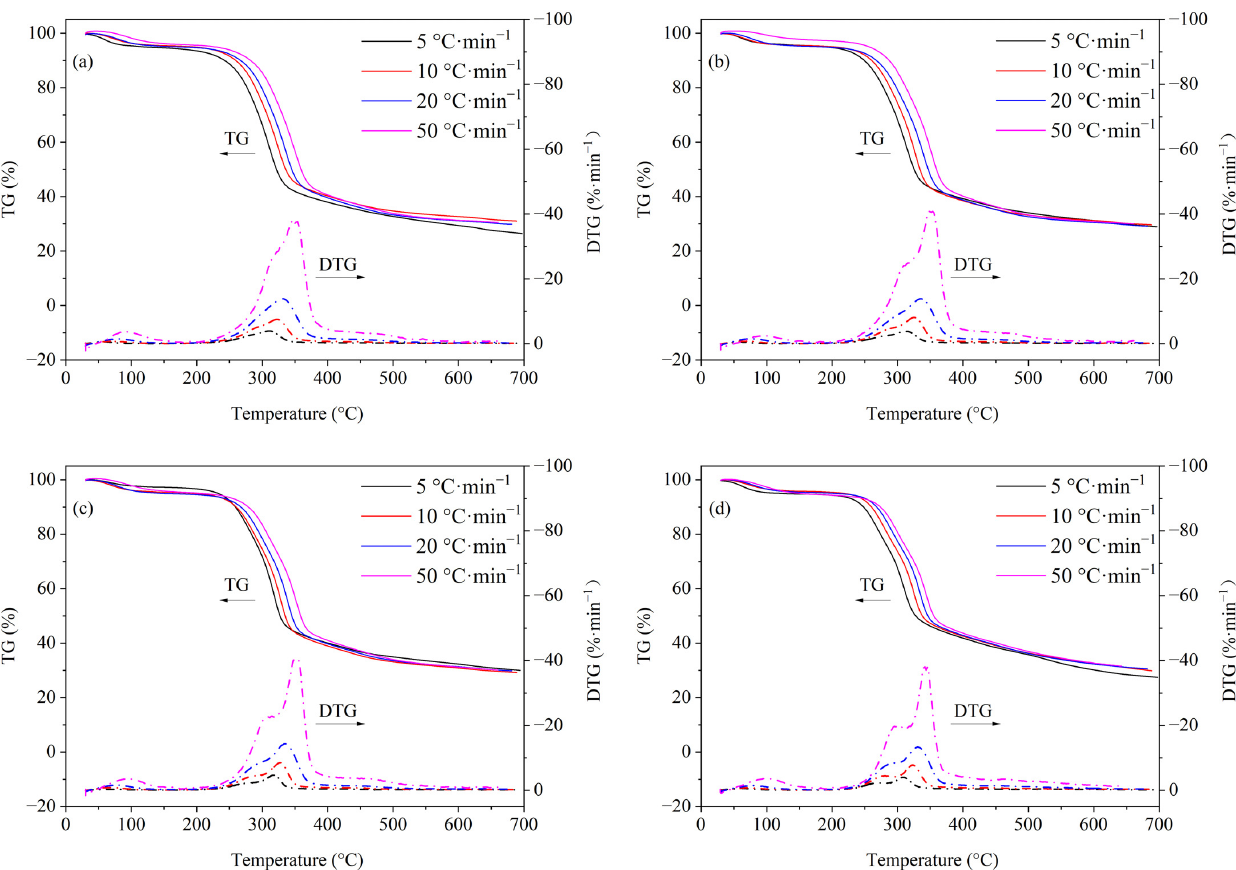
Figure 6. TG and DTG curves of rice straw with different Cd loading. ( a ) RS, ( b ) RS-0.1%Cd, ( c ) RS-1%Cd, and ( d ) RS-5%Cd. ( c ) RS-1%Cd, and ( d )